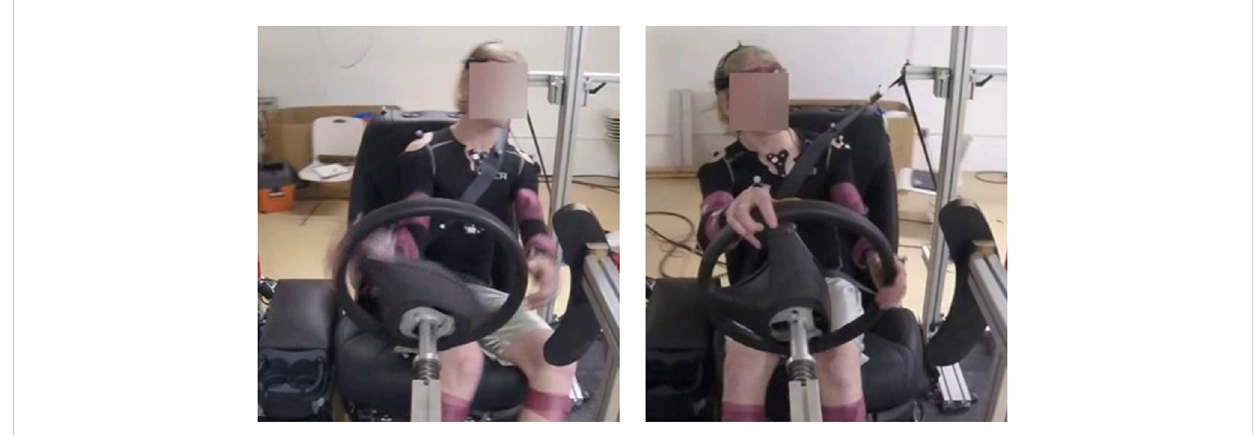
Drivers ’ motion during the lateral sled perturbation, consisting of fi rst a right swerve and motion into the belt (left image), followed by a left swerve and motion out of the belt (right